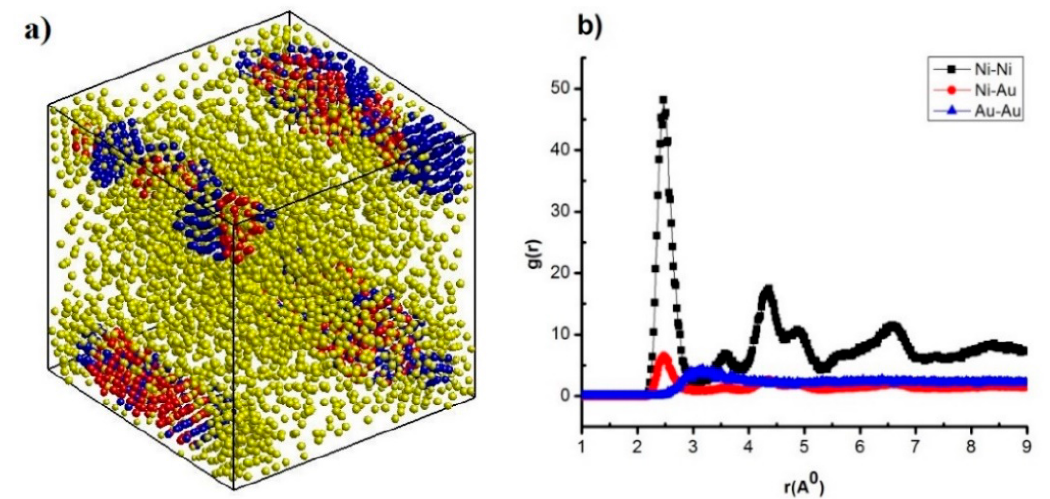
Figure 3. The structural shape ( a ), radial distribution function ( b ) of NiAu 5324 alloy at heating rates of 4 × 10 12 K/s. Table 3. The structural features such as links Ni-Ni, Ni-Au, Au-Au include r and g(r) with a different atomic number (N). NiAu 5324 Alloy